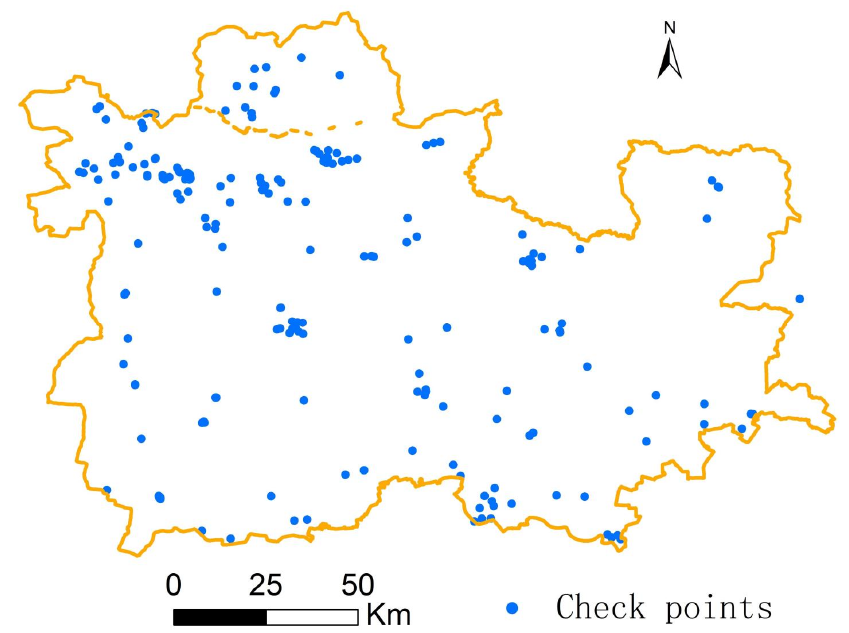
Figure 5. Distribution of verification points for the authenticity of elevation change. Table 3. Verification and evaluation of elevation change accuracy.